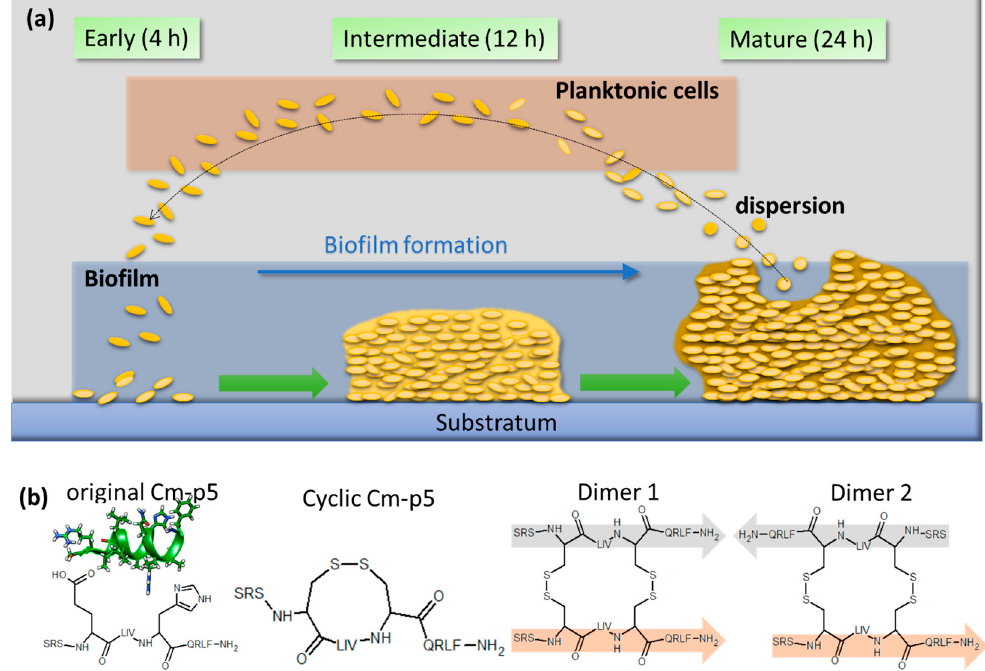
Figure 1. Schematic overview of C. auris biofilm development and the structure of the antifungal Cm-p5 peptide and its derivatives. ( a ) Classification of the three major steps in biofilm formation of C. auris . The early phase (4 h) is characterized by the adhesion of planktonic cells to the substratum. Proliferation and extracellular matrix production take place in the intermediate phase (12 h). The mature biofilm features the production of virulence factors and dispersion of planktonic cells from the biofilm (24 h). ( b ) Structure of the original Cm-p5 and its helical stabilized derivatives. NMR structure shown for the original helical Cm-p5 peptide can be accessed in the RSCB protein data bank (PDB: 2MP9).